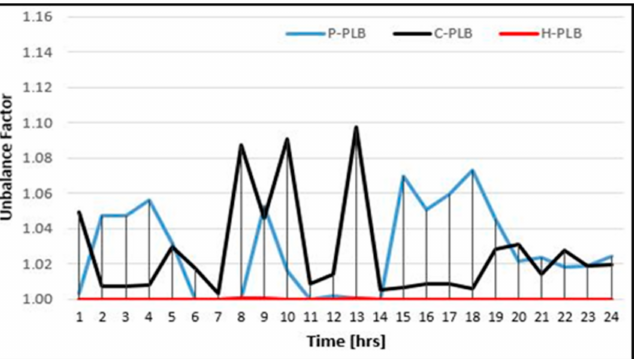
Figure 17. Comparison between the hourly UF obtained in the analysed cases (P-PLB, C-PLB, and H-PLB).